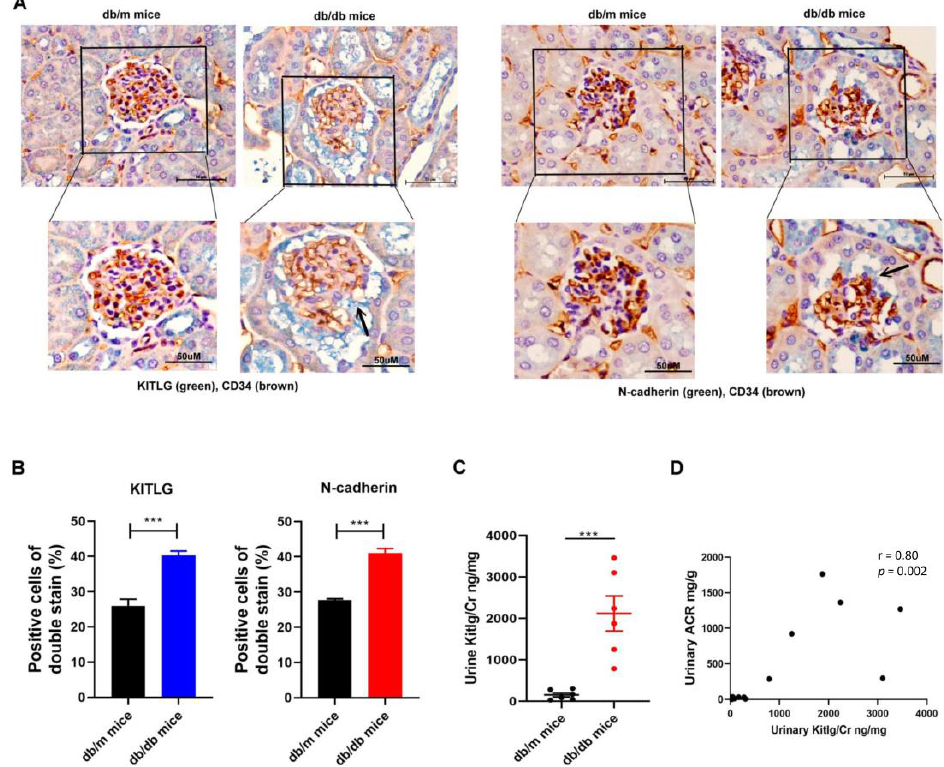
Figure 5. Positive relationship between KITLG expression and kidney dysfunction in mice with DN. ( A , B ) The expression of KITLG and N-cadherin in GECs of kidneys in mice is shown. The kidney ( A , B ) The expression of KITLG and N-cadherin in GECs of kidneys in mice is shown. The kidney sections of non-diabetic db/m mice and diabetic db/db mice were co-stained with KITLG (green) sections of non-diabetic db/m mice and diabetic db/db mice were co-stained with KITLG (green) and and CD34 (brown), as the marker of GECs. ( C ) Urinary KITLG levels were measured in db/m mice CD34 (brown), as the marker of GECs. ( C ) Urinary KITLG levels were measured in db/m mice ( n = 6) ( n = 6) and db/db mice ( n = 6) using ELISA. ( D ) The correlation between urinary KITLG levels and and db/db mice ( n = 6) using ELISA. ( D ) The correlation between urinary KITLG levels and urinary urinary albumin/creatinine ratio (ACR). Urine albumin was measured using an immunoturbidimet- albumin/creatinine ratio (ACR). Urine albumin was measured using an immunoturbidimetric assay, and ric assay, and urine creatinine was determined by an enzymatic method. The bar graph represents the mean ± S.E.M. of at least three independent experiments. *** p < 0.001 by Student ’s t -test; the p - urine creatinine was determined by an enzymatic method. The bar graph represents the mean ± S.E.M. of value of the correlation was assessed by Spearman analysis. at least three independent experiments. *** p < 0.001 by Student’s t -test; the p -value of the correlation was assessed by Spearman